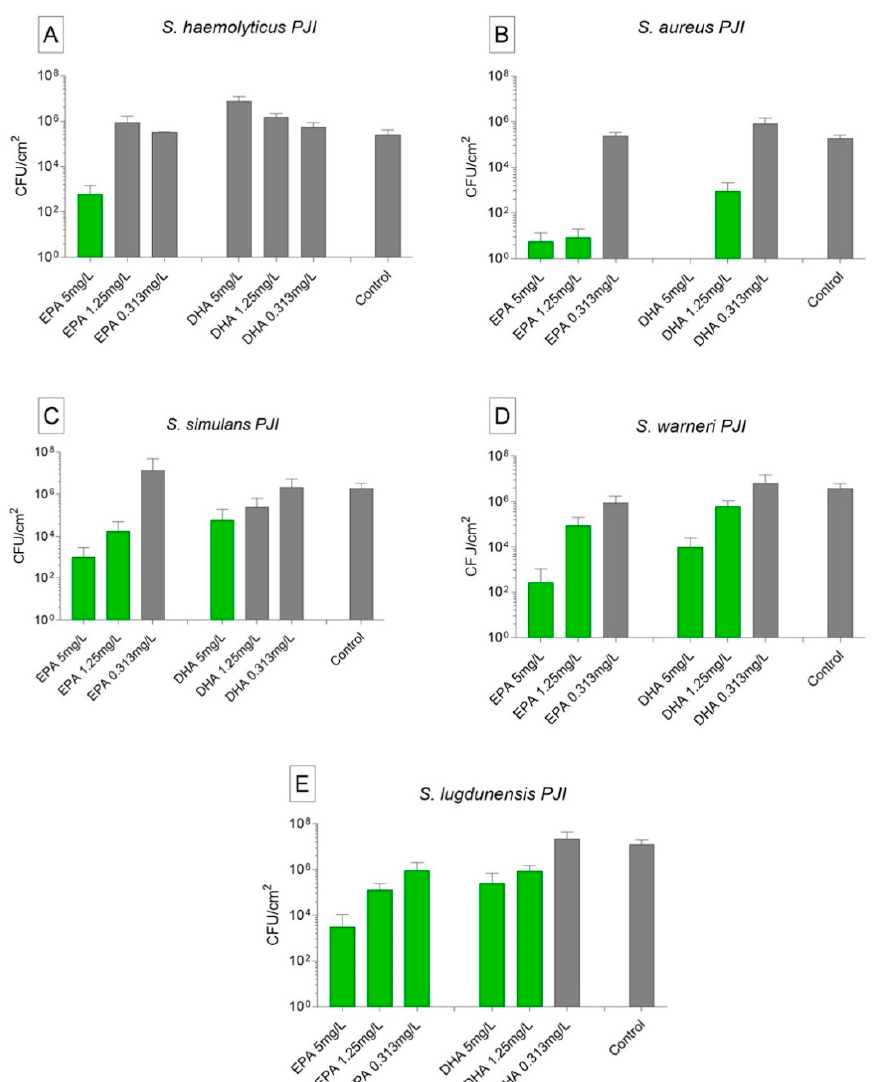
Figure 5. Activity of ω -3 PUFAs on biofilm killing-treatment of biofilms with EPA and DHA, and only with nutrient medium as control. The data are stated as mean ± SEM. ( A ) S. haemolyticus PJI isolated; ( B ) S. aureus PJI isolated; ( C ) S.simulans PJI isolated; ( D ) S. warneri PJI isolated; ( E ) S. lugdunensis PJI isolated. In green, values significantly different from control group ( p < 0.0001). Statistically analyzed with two-way ANOVA and Turkey’s multiple comparison tests. All the tests were repeated twice and carried out in triplicates.